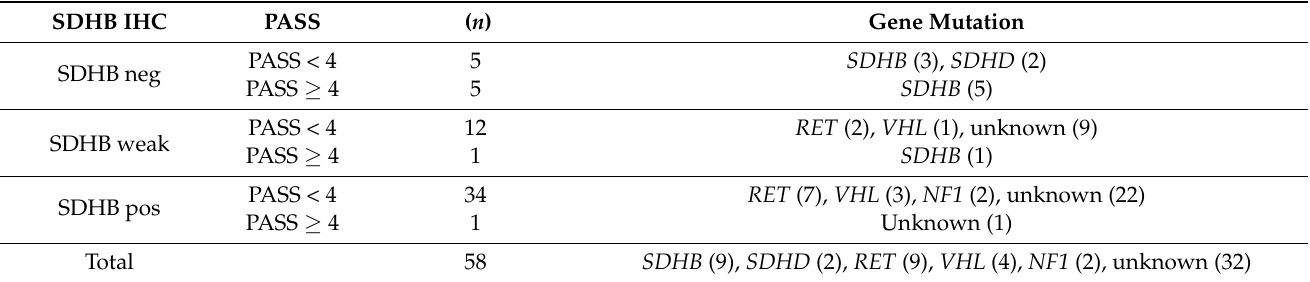
Table 2. Summary of 58 patients with